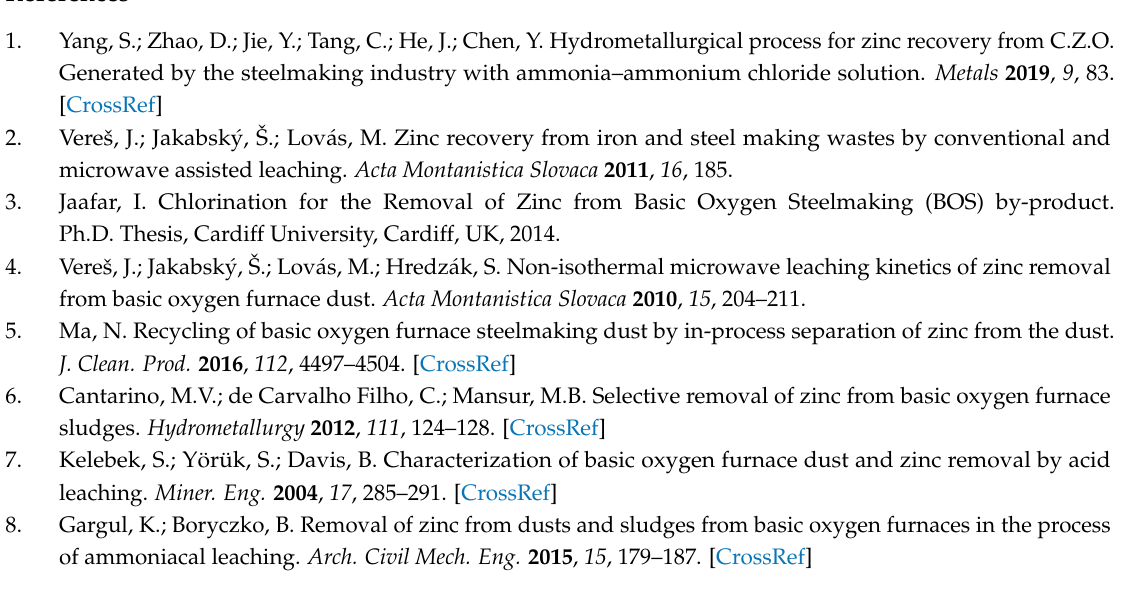
Figure S1: Progress of leaching of ( a ) Zn and ( b ) Fe from BOS-3 using 1.0 M butyric acid with different L/S stoichiometric ratios, Table S1: The pH variations obtained from the leachates for the three BOS filter cakes under different leaching